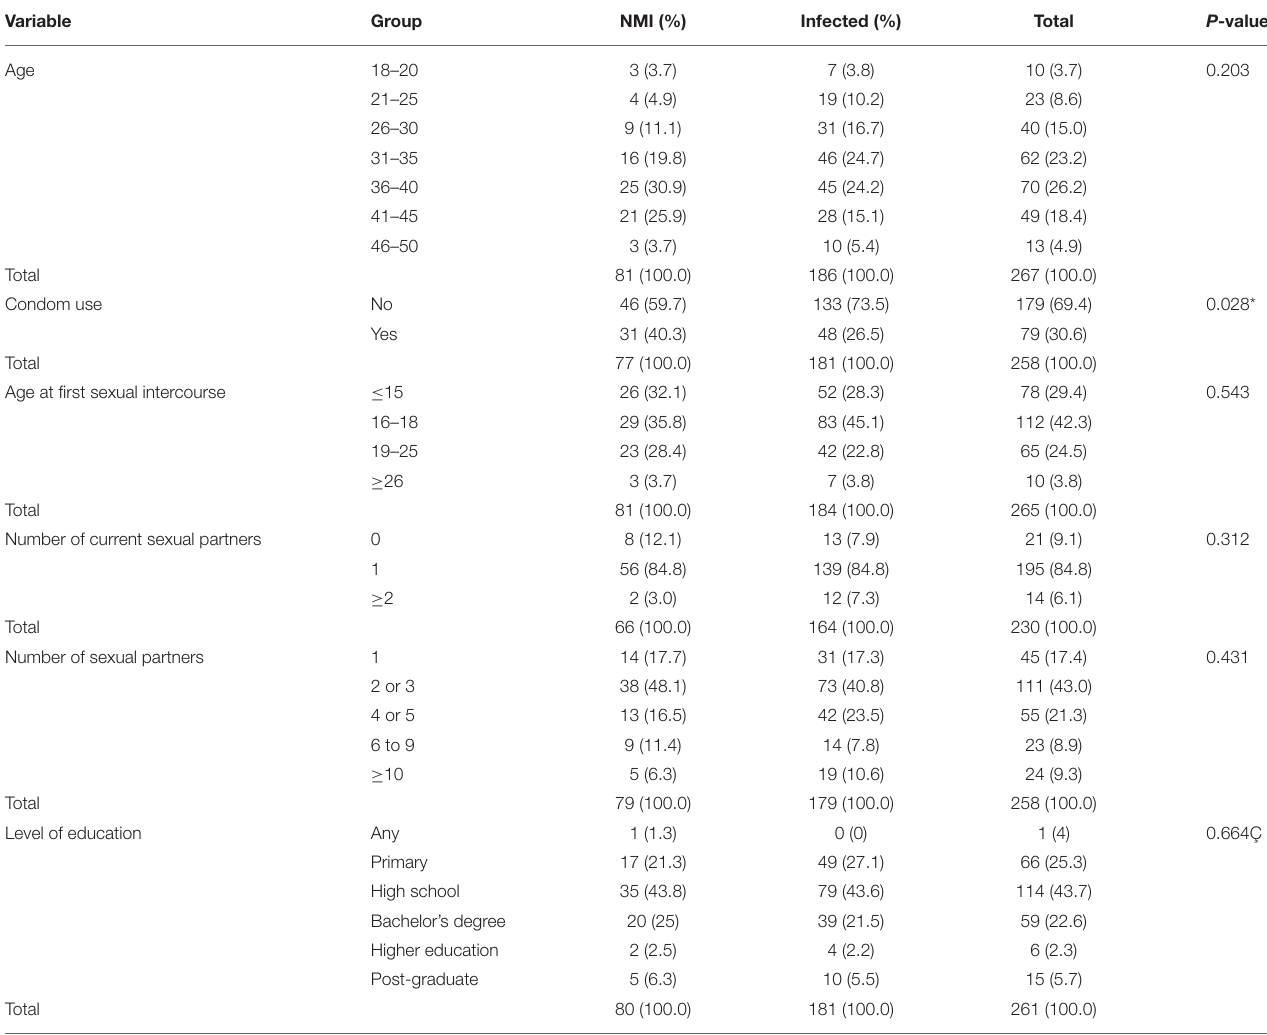
TABLE 2 | Main variables affecting infection frequency among HIV + subjects.